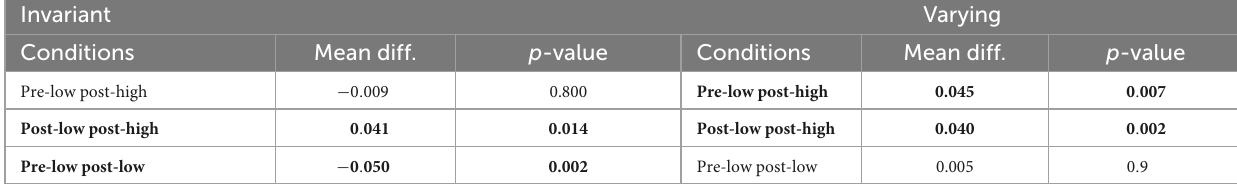
TABLE 3 Statistical inference of active information storage (AIS) for invariant and varying networks.